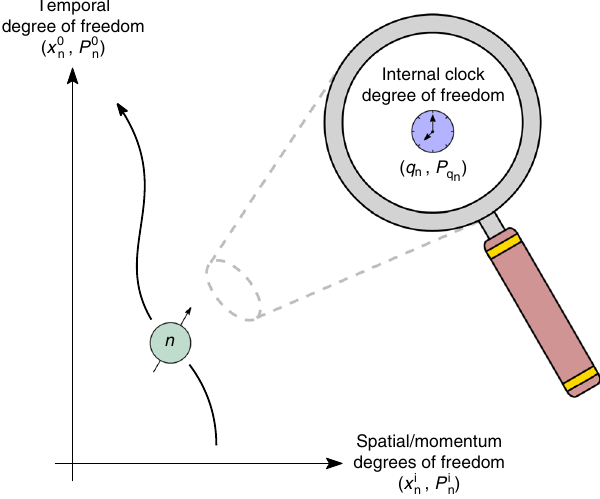
; P i Þ of the n th n n